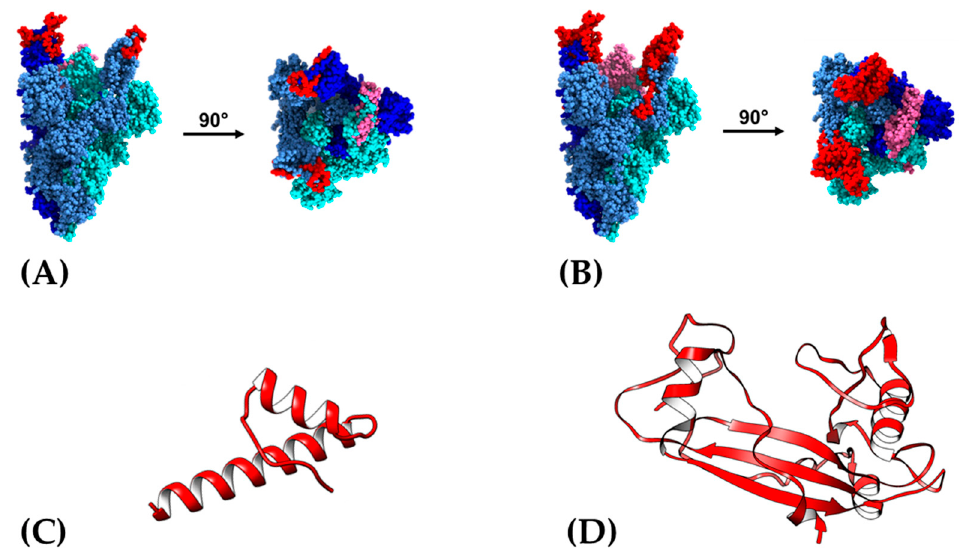
Figure 2. Structure of the NG06 and NG19 antigens. ( A ) NG06 region highlighted in the Spike protein, ( B ) NG19 region highlighted in the Spike protein. De novo predicted three-dimensional structure for NG06 ( C ) and NG19 ( D ) peptides. ( A , B ) Each monomer is shown in different shades of blue and the NG06 and NG19 regions within the RBD (open states RBD are showed in red and closed state in pink).After structural modeling,